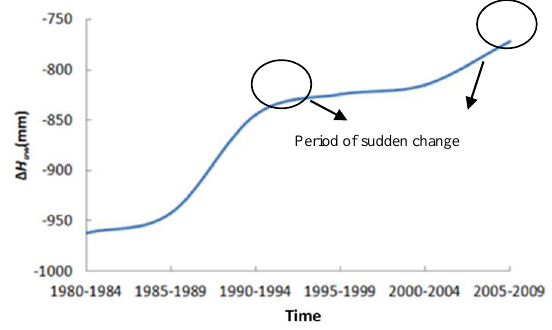
Figure 5. Variations in the groundwater quantity from 1980–2009.